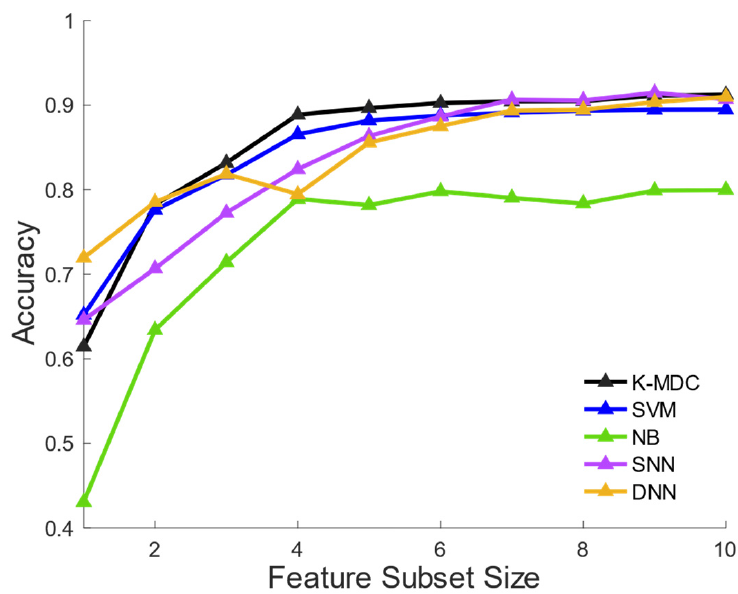
Figure 4. Performance comparisons between K-MDC, SVM, SNN, DNN, and NB while increasing the number of features. Table 3. Minimum required number of features to achieve specific detection accuracies. ‘-’ indicates that the classifier could not achieve the required accuracy threshold using our